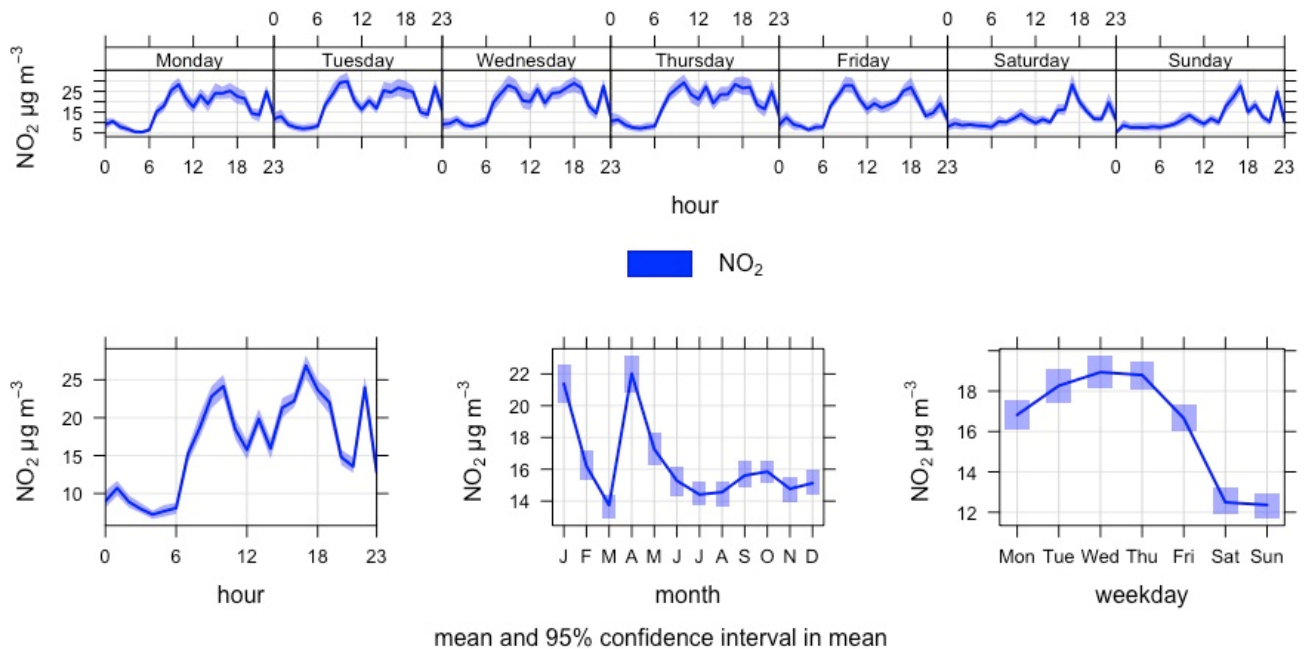
Figure 10. Time variation plot of NO 2 concentration at Helsinki West Harbour in 2019. Table 8. Multivariable linear regression analysis results for vessel arrivals, departures, movement and laying alongside to the logarithm of NO 2 hourly mean concentrations controlled for wind di- rection, wind speed and time of day at West Harbour in 2019. p -values less than 0.05 in bold.